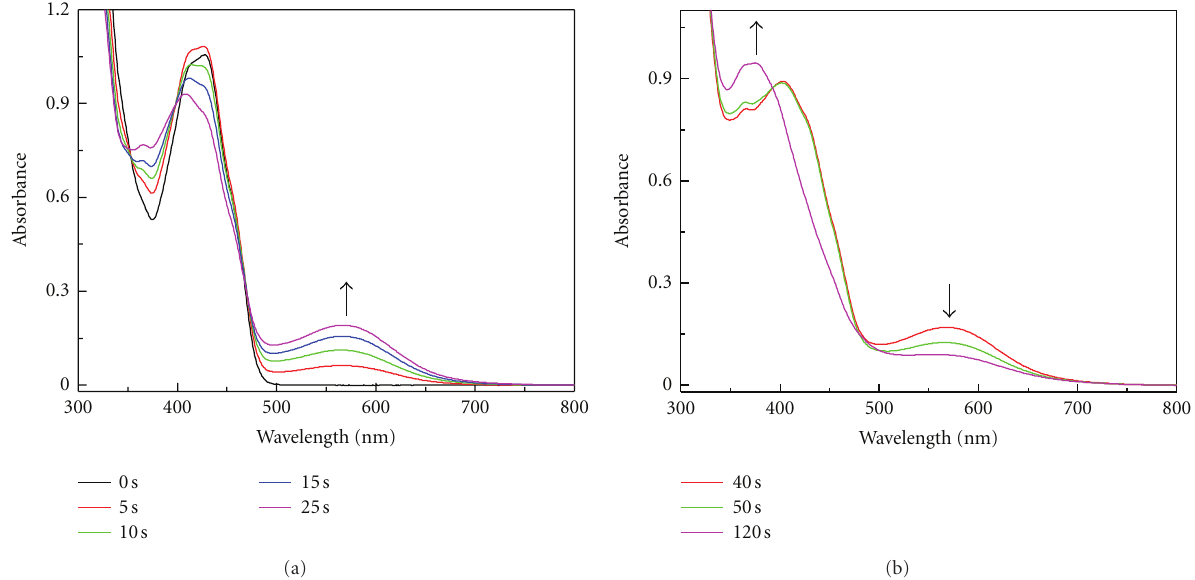
Figure 4: Electronic absorption spectra obtained during photolysis of the dye 1 (0.1 mM) and Tz (1mM) in MP solution containing 0.37 M TMPTA in the presence of air. Irradiation intensity 6 × 10 16 quants − 1 .